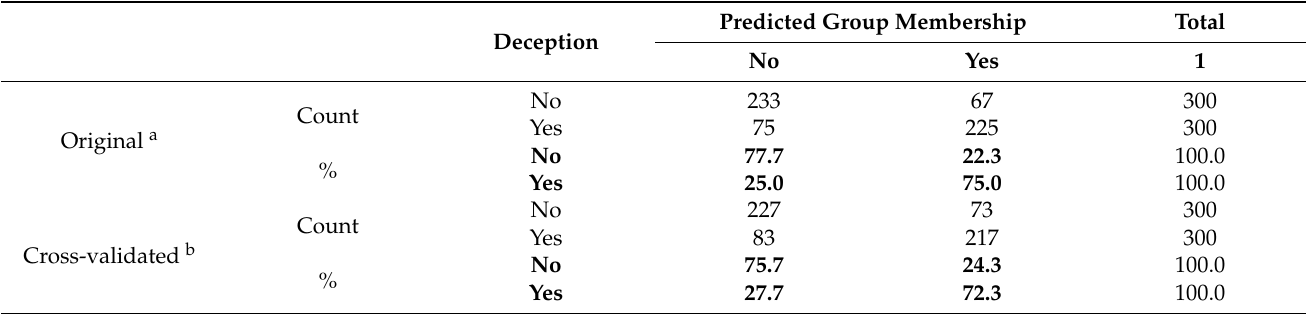
Table 2. Classification results from DFA (IBM